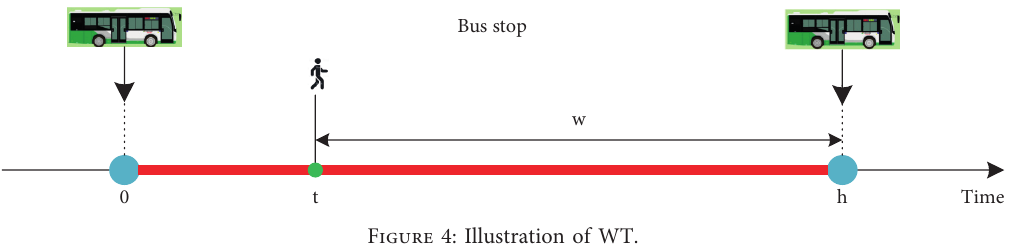
Figure 4: Illustration of